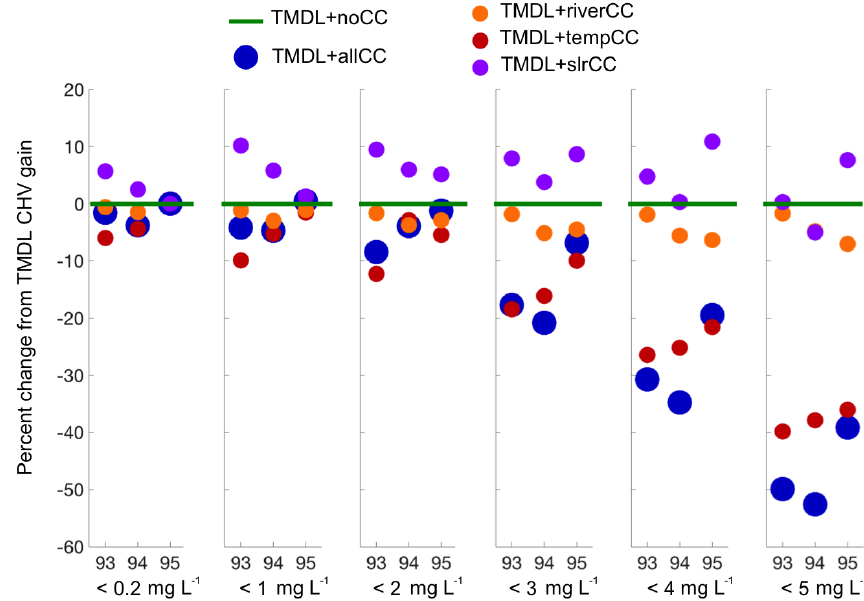
Figure 5. Percent change due to climate change, relative to the improvement in CHV between the TMDL + noCC scenario and Base + noCC